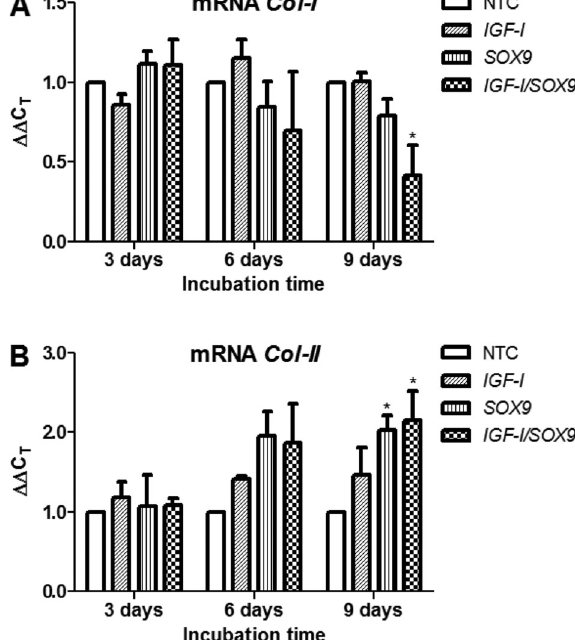
Figure 2. Relative Col-I and Col-II gene expression by quan- titative RT-PCR. Data are reported as the average and standard deviation of the 9 assessments of the expression level of the analyzed genes in non-transfected chondrocytes (NTC) or those that were transfected with pCMV-SPORT6 IGF-I ( IGF-I ), pCMV-SPORT6 SOX9 ( SOX9 ), or with both plasmids ( IGF-I/SOX9 ). The gene expressions of Col-I ( A ) and Col-II ( B ) were normalized to the GAPDH expression levels. *P o 0.05 vs NTC (two-way ANOVA with Bonferroni post hoc